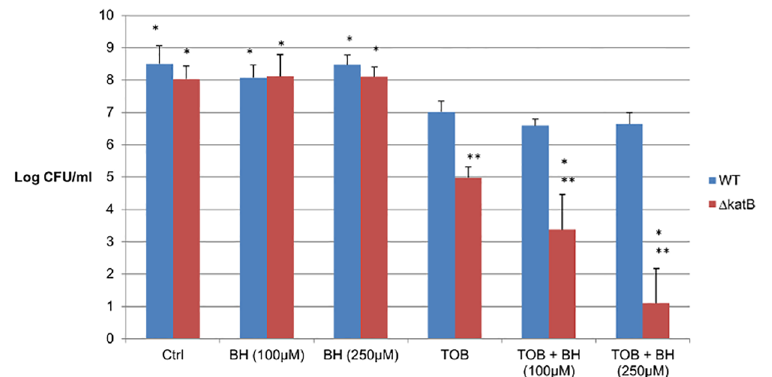
Fig 3. Potentiating effect of BH in B . cenocepacia Δ katB . Data shown are the average log(CFU/ml) recovered after 24h treatment of mature biofilms of B . cenocepacia C5424 (WT) and its catalase deletion mutant ( Δ katB ) with 4 x MIC TOB (MIC for both strains = 128 μg/ml), and TOB in combination with BH (100 μM and 250 μM). (cid:3) : significant difference (p < 0.05) compared to TOB alone (cid:3)(cid:3) : significant difference (p < 0.05) compared to the wild type. Error bars represents SD (n =